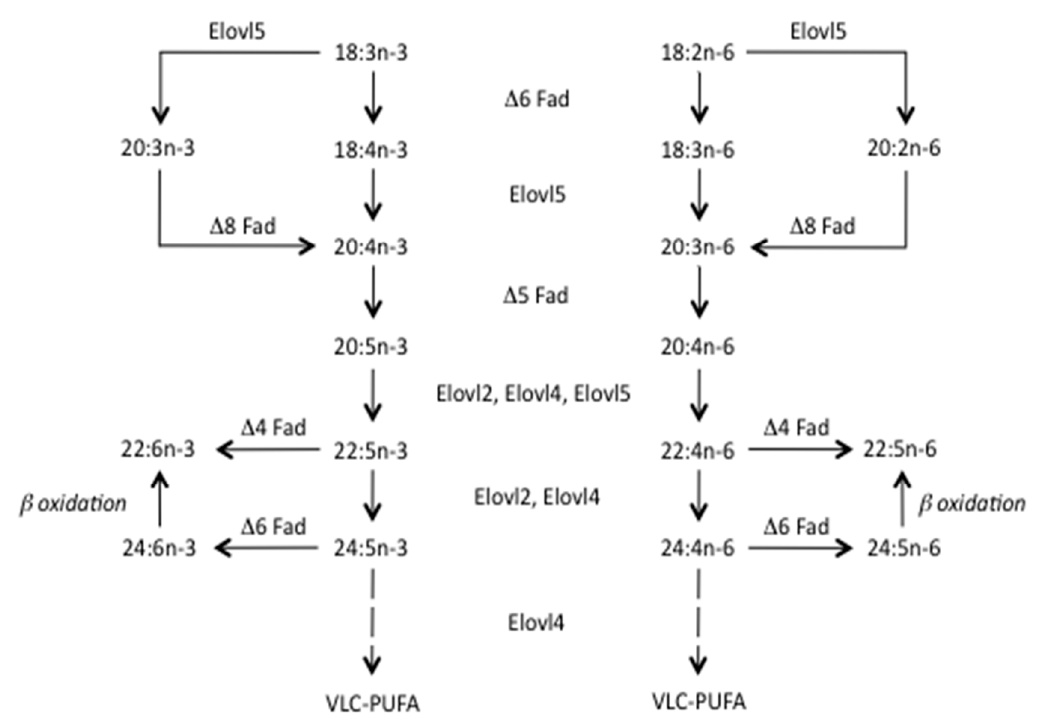
Figure 1. Pathways of long-chain polyunsaturated fatty acid biosynthesis in humans and fish. All activities other than ∆ 4 desaturation ( ∆ 4 Fad) are present in humans. Similarly, all activities have been demonstrated in teleost fish species, although not all species express all activities. The presence of ∆ 4 Fad enabling direct production of 22:6n-3 from 22:5n-3 has only been demonstrated in a few teleost fish species and, therefore, DHA (22:6n-3) production from EPA (20:5n-3) in most fish species and humans is only possible via the Sprecher shunt [1]. ∆ 4 Fad, ∆ 5 Fad and ∆ 6 Fad, fatty acyl desaturases; DHA, docosahexaenoic acid; EPA, eicosapentaenoic acid; Elovl2, Elovl4 and Elovl5, fatty acid elongases. Reproduced by permission from Tocher [2].